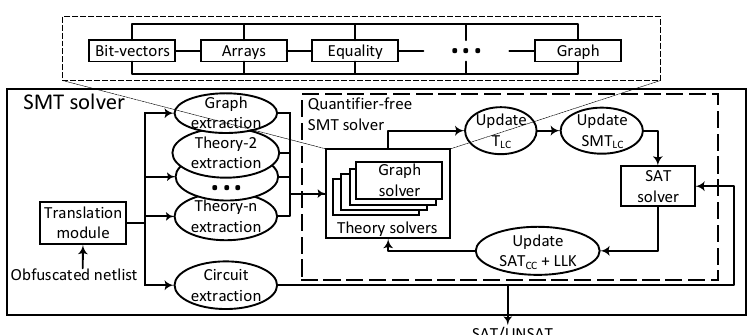
Figure 4: Overall Architecture of SMT Attack for Circuit Deobfuscation. In SMT attack multiple theory solvers could be simultaneously invoked along with a SAT solver to model complex attack scenarios.